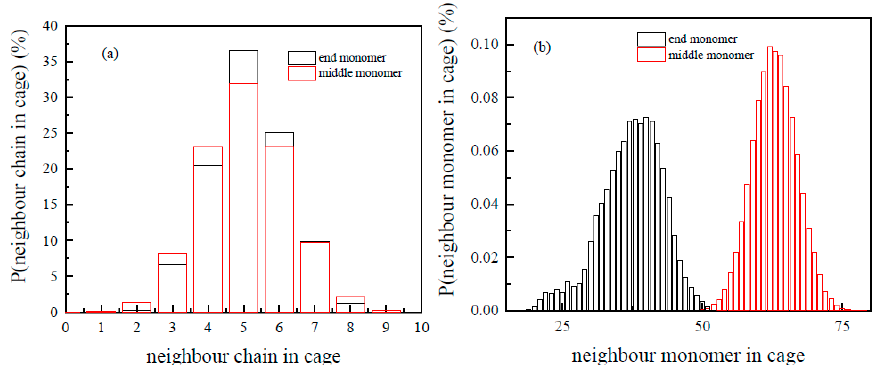
Figure 2. The radial and number distribution functions for chain ends ( a ) and monomers in the middle of chains ( b ) at 393 K. Here, we used the main chain carbon which connected to phenyl ring to represent a monomer.